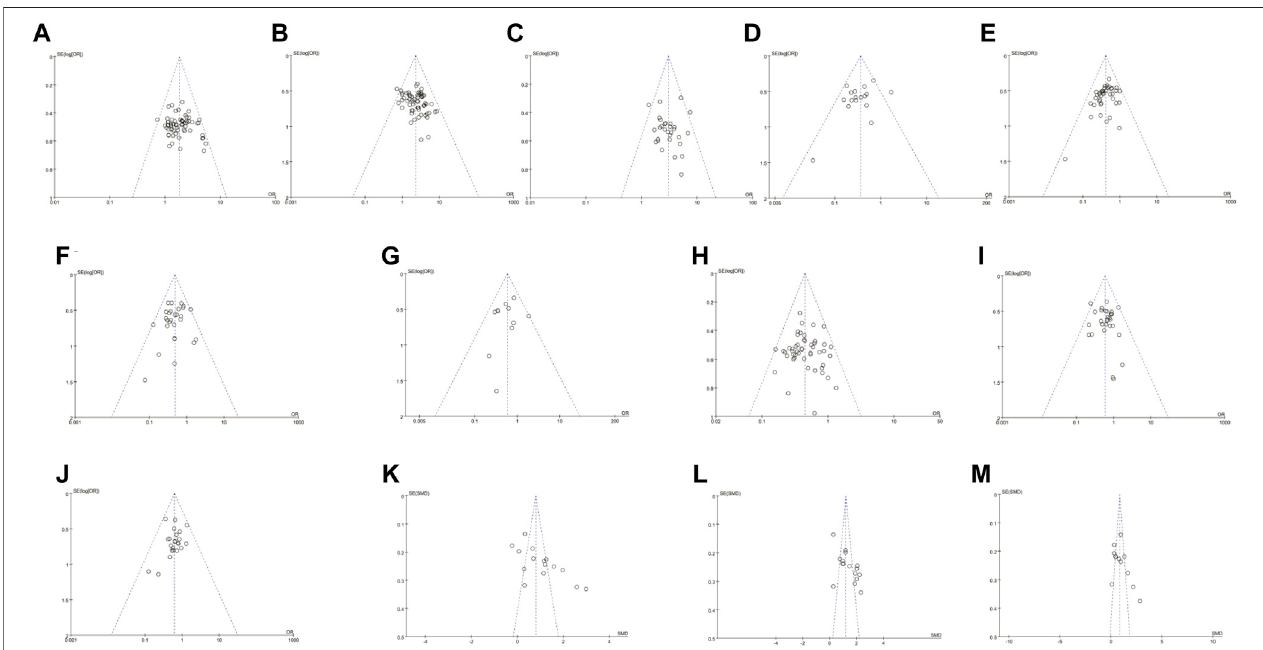
FIGURE 7 | The analysis ofpublication bias. There was asigni fi cantpublication bias for DCR, neutropenia, CD3 + T cells, and CD3 + CD4 + T cells (p (cid:1) 0.02, 95% CI 0.21 to 2.28; p (cid:1) 0.03, 95% CI – 2.24 to – 0.13; p (cid:1) 0.01, 95% CI 3.94 to 16.11; and p (cid:1) 0.001, 95% CI 4.04 – 13.58). Note: ORR, objective response rate; DCR, disease control